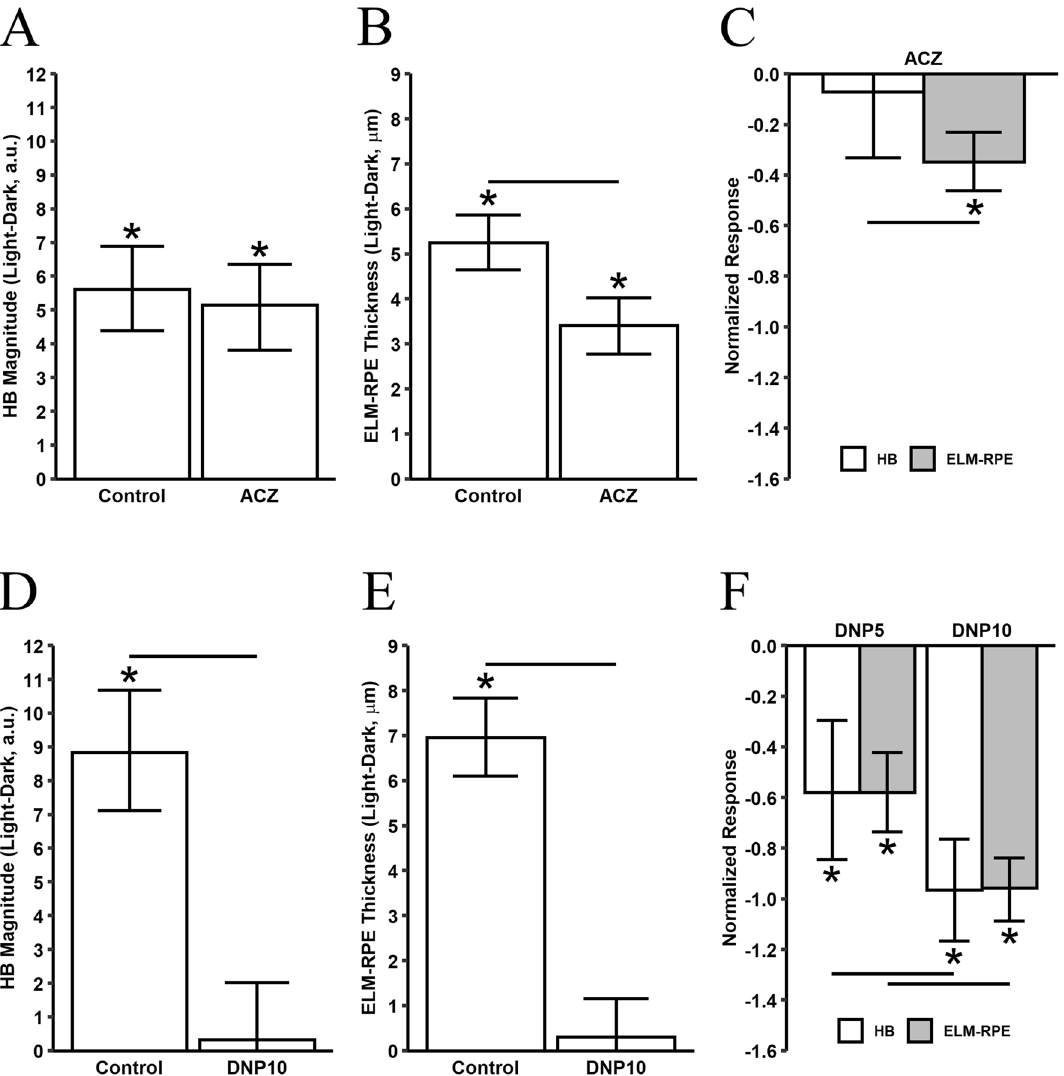
Figure 2. Effect of ACZ and DNP on outer retina responses. Light–dark difference of HB magnitude (A,D) and ELM-RPE thickness (B,E) for control (baseline) and after ACZ and DNP (10 mg/kg) treatments, respectively. ˜ ˜ ˜ ˜ Y represents the mean Y control )/ Y control in light–dark differences ( Y drug − (C,F) Normalized drug response ( light–dark difference) in HB magnitude and ELM-RPE thickness for control and mice treated with ACZ and DNP (at two dosage, 5 and 10 mg/kg). All error bars represent 95% credibility intervals, an asterisk indicates the credibility interval excludes 0 (equivalent to statistically significant), and a line between two bars indicates that the credibility interval of the difference between the two estimates are statistically significant. (ACZ, n = 10 mice; DNP at 10 mg/kg, n = 5 mice; DNP at 5 mg/kg, n = 6